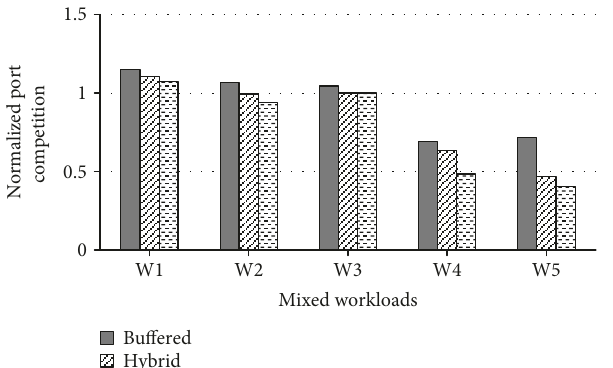
Figure 12: Normalized port competition rate of hybrid loads in 64 threads.